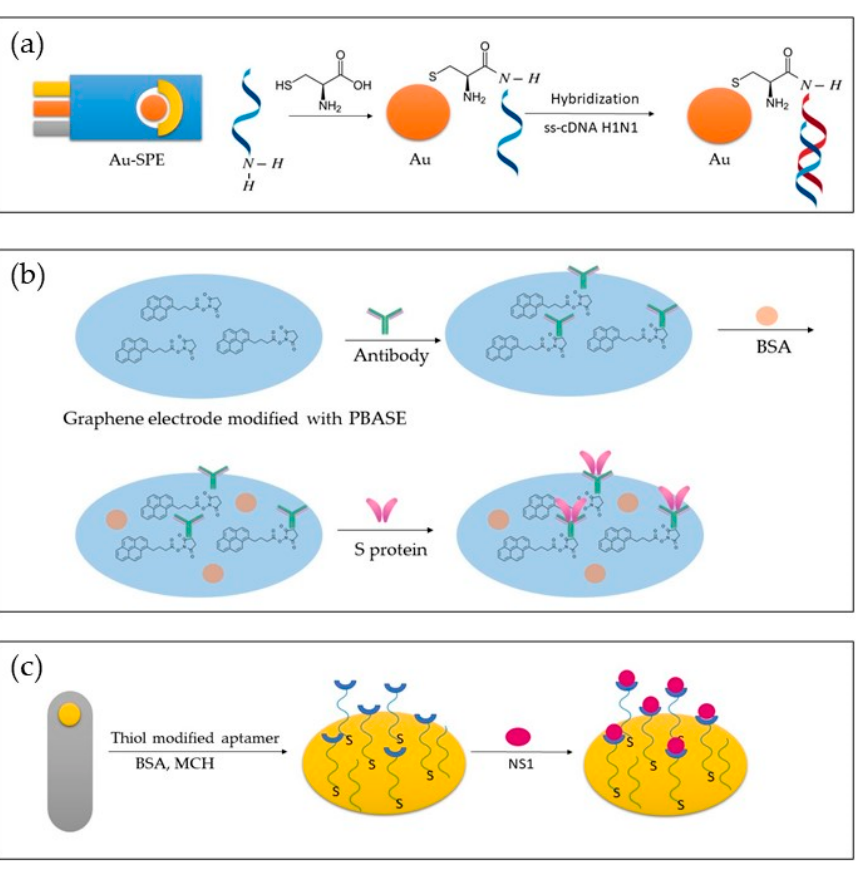
Figure 3. Representation of different approaches in the development of genosensors ( a ), immunosensor ( b ), and aptasensor ( c ).